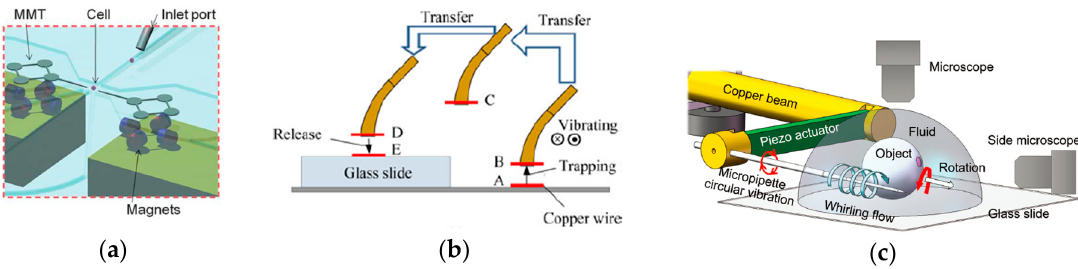
Figure 5. Several vibrated-needle-driven manipulators: ( a ) Hagiwara et al. [64,65]. The rear end of the needle is connected to a square base that can be rotated and translated by the magnet below. An ultrasound stream is applied to the operation units consisting of needle and base to suspend these units stably in the liquid, but the needle manipulates the cells in a contact operation. (Republished with permission of the Royal Society of Chemistry from reference [65]. Copyright © The Royal Society of Chemistry 2011; permission conveyed through Copyright Clearance Center, Inc.) ( b ) The methods proposed by Li and Chen et al. [30,66] generate high-frequency vibration (~100 kHz) to form acoustic microstreaming, which can trap tiny objects near the tip to realize movement. (Reprinted from [30], with the permission of AIP Publishing.) ( c ) Liu et al. [28,67] proposed a universal and e ffi cient operating system. The needle tip is fixed to a movable piezoelectric actuator that generates a micro-vortex in the liquid medium through low-frequency vibration (~350 Hz) to drive the particle to move and rotate. (Republished with permission of the John Wiley and Sons from reference [28]. Copyright © 2018, the John Wiley and Sons; permission conveyed through Copyright Clearance Center,